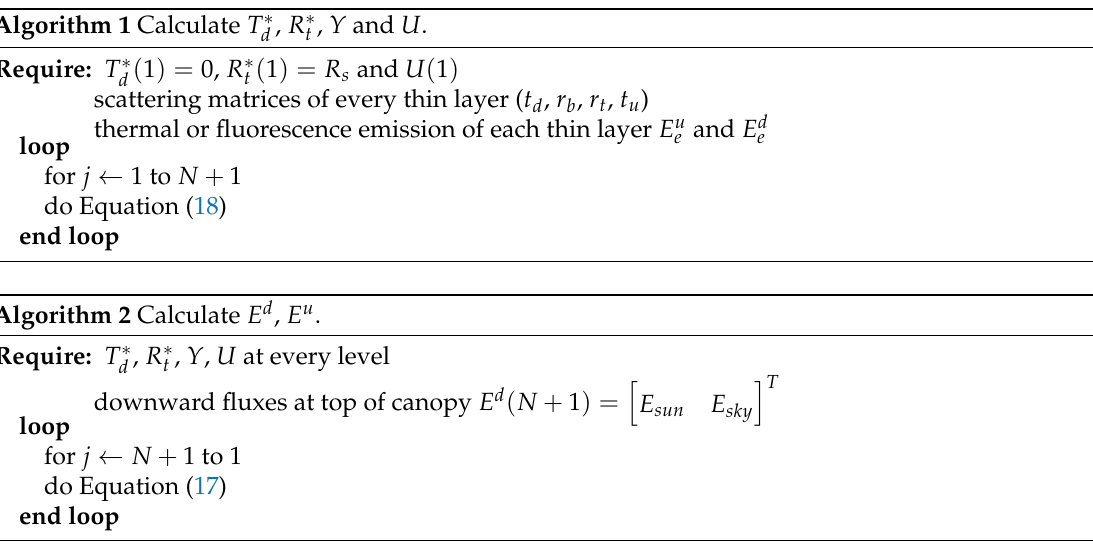
Algorithm 1 Calculate T ∗